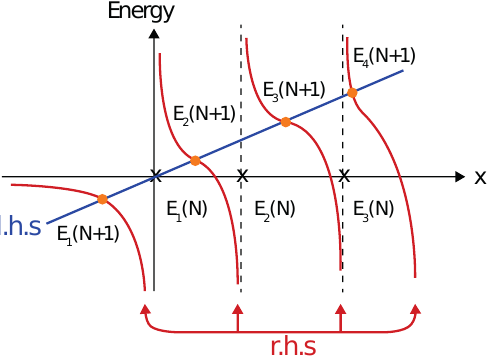
Figure 2. A schematic representation of the both sides of Equation (6) as a function of x . Singularities are obtained when x equals one of the eigenvalues of H ( N ) (crosses on the x axis), while the intersection are achieved when x corresponds to one of the eigenvalues of H ( N + 1 ) (orange